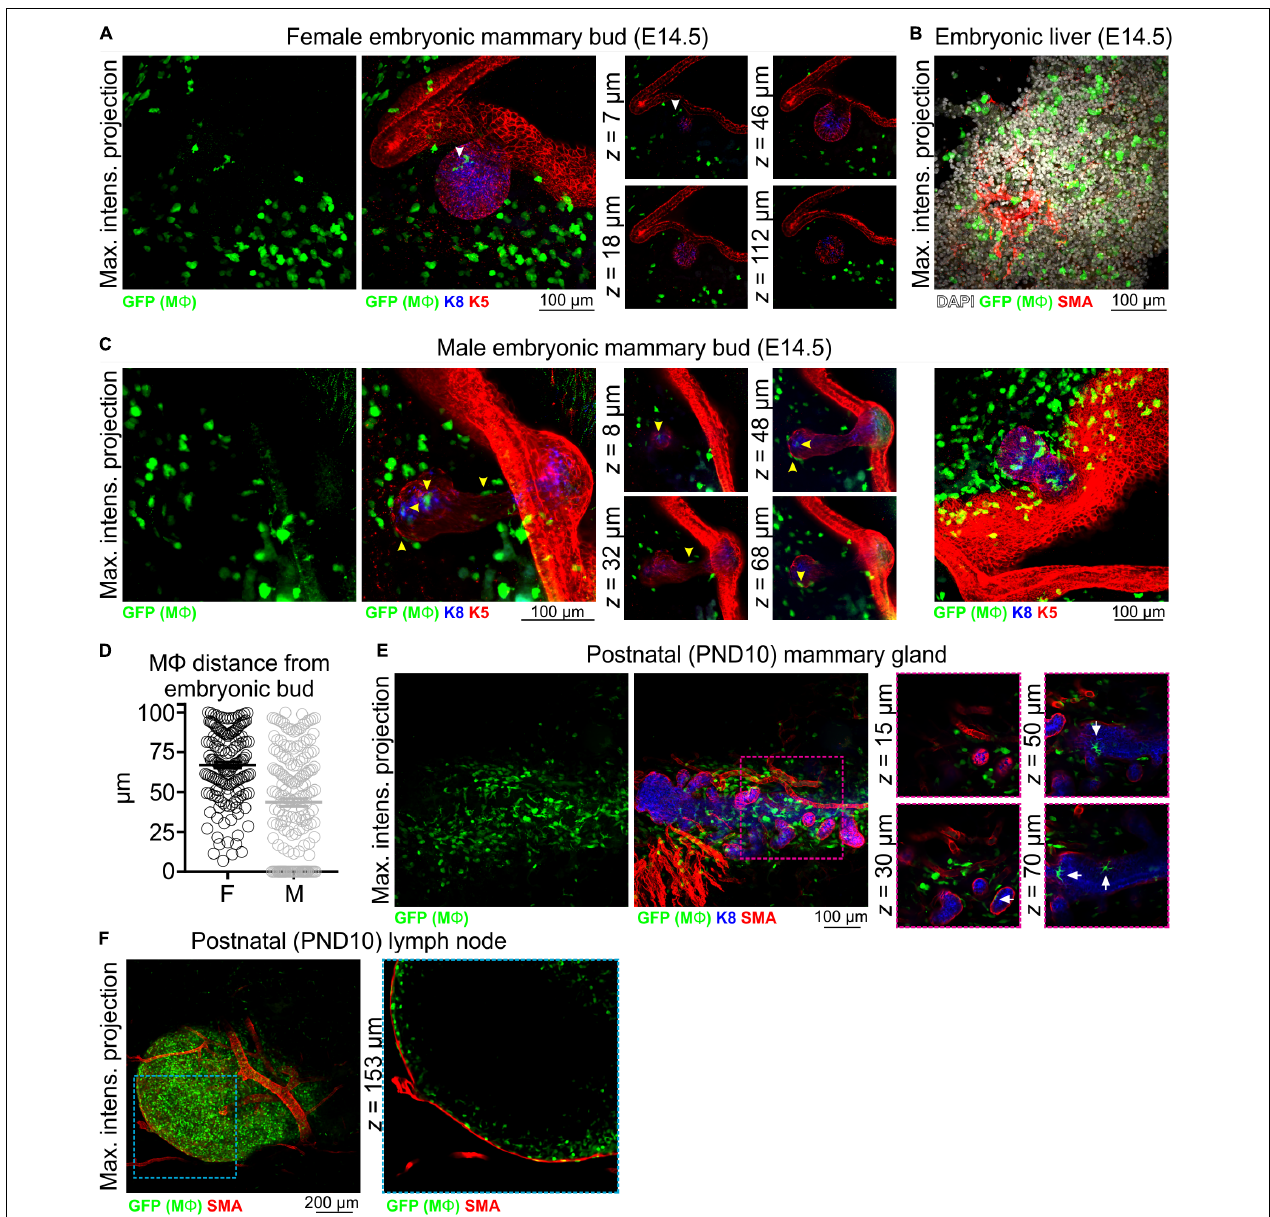
FIGURE 1 | M φ s in the embryonic and early postnatal mouse mammary gland. Maximum intensity z -projection and single optical ( z ) slices of cleared tissue from (A,B) embryonic (E14.5) female mice and (C) embryonic (E14.5) male mice. (D) The distance of M φ s (within a 100 µ m radius) of the female and male embryonic buds. M φ s contacting the bud or inside of the bud were assigned a value of 0; this was only observed in male embryos. (E) Mammary tissue from postnatal day (PND) 10 Csf1r-EGFP female mice. (F) Inguinal lymph node from PND10 mice showing subcapsular sinus M φ s. Keratin (K) 8 immunostaining shows K8-positive luminal cells; K5 immunostaining reveals K5-expressing basal cells; smooth muscle actin (SMA) immunostaining reveals basal cells and SMA-positive vessels. White arrowhead in (A) points to a M φ that appears to be in contact with the embryonic bud in the maximum intensity projection, but is revealed to be positioned in the mammary mesenchyme above the bud in optical slices. Yellow arrowheads in (C) point to M φ s that are in direct contact with the embryonic bud. Arrows in (E) point to M φ s that are in contact with the PND10 mammary epithelium. Images are representative of 3 mice/embryos at each developmental